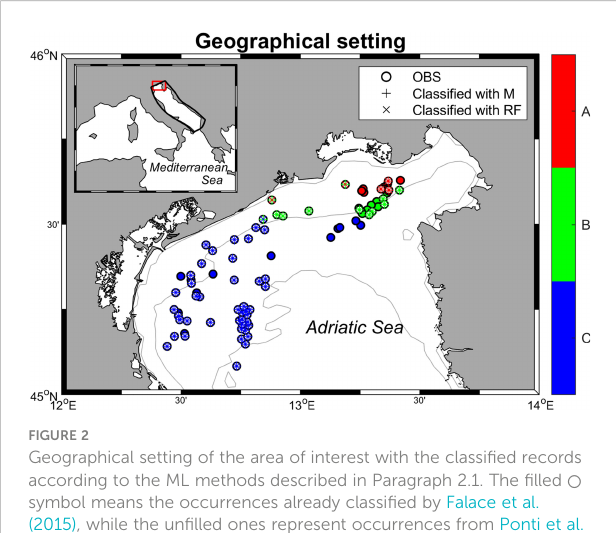
FIGURE 2 Geographical setting of the area of interest with the classi fi ed records according to the ML methods described in Paragraph 2.1. The fi lled ○ symbol means the occurrences already classi fi ed by Falace et al. (2015), while the un fi lled ones represent occurrences from Ponti et al. (2005) and Martin et al. (2014). + symbol visualizes the records classi fi ed in the habitat typology with MaxEnt (M) and × stands for Random Forest (RF). Each color represents a habitat